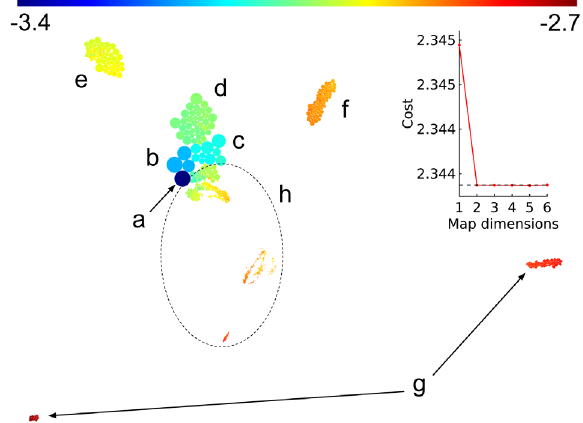
15. Labeled 2D SHEAP map produced from local minima on the LJ 13 PES (the same set as depicted in Fig. 2), described by sorted lists of inverse pairwise distances. The projection uses a perplexity of 30, with a minimum sphere radius R 0 ¼ 0 . 01 . The circles representing each structure are colored according to energy per atom in Lennard-Jones units; see the color bar at the top of the figure. Basin volumes are represented by the area of each circle. Groups of structures are labeled according to their clustering in Fig. 2; the dashed line encloses structures collec- tively labeled (h). Also shown is a plot of the lowest cost (without hard-sphere interactions) obtained by projections of a subset of this dataset into a range of map